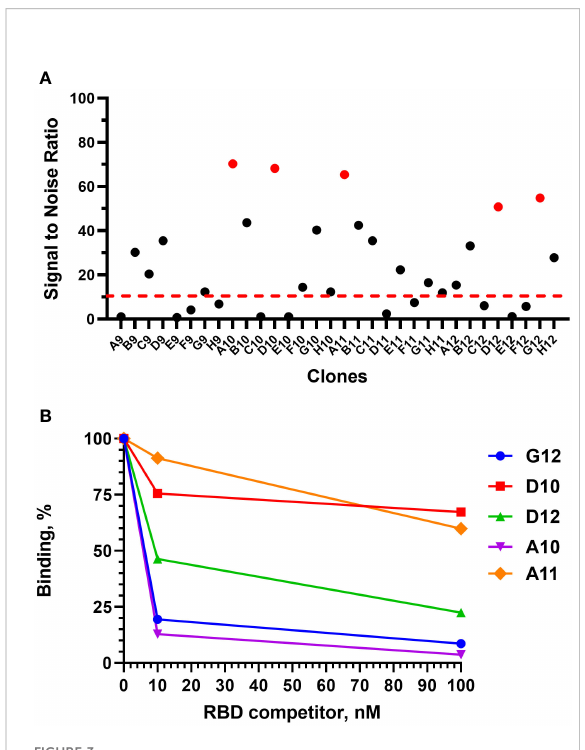
FIGURE 3 Monoclonal ELISA of selected VHH clones (pointed red) (A) and competitive phage ELISA (B) . Dashed red line – S\N